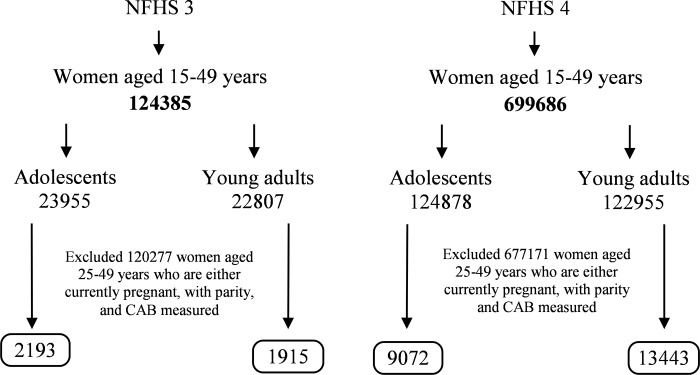
Analytical sample and sample size used in the study.